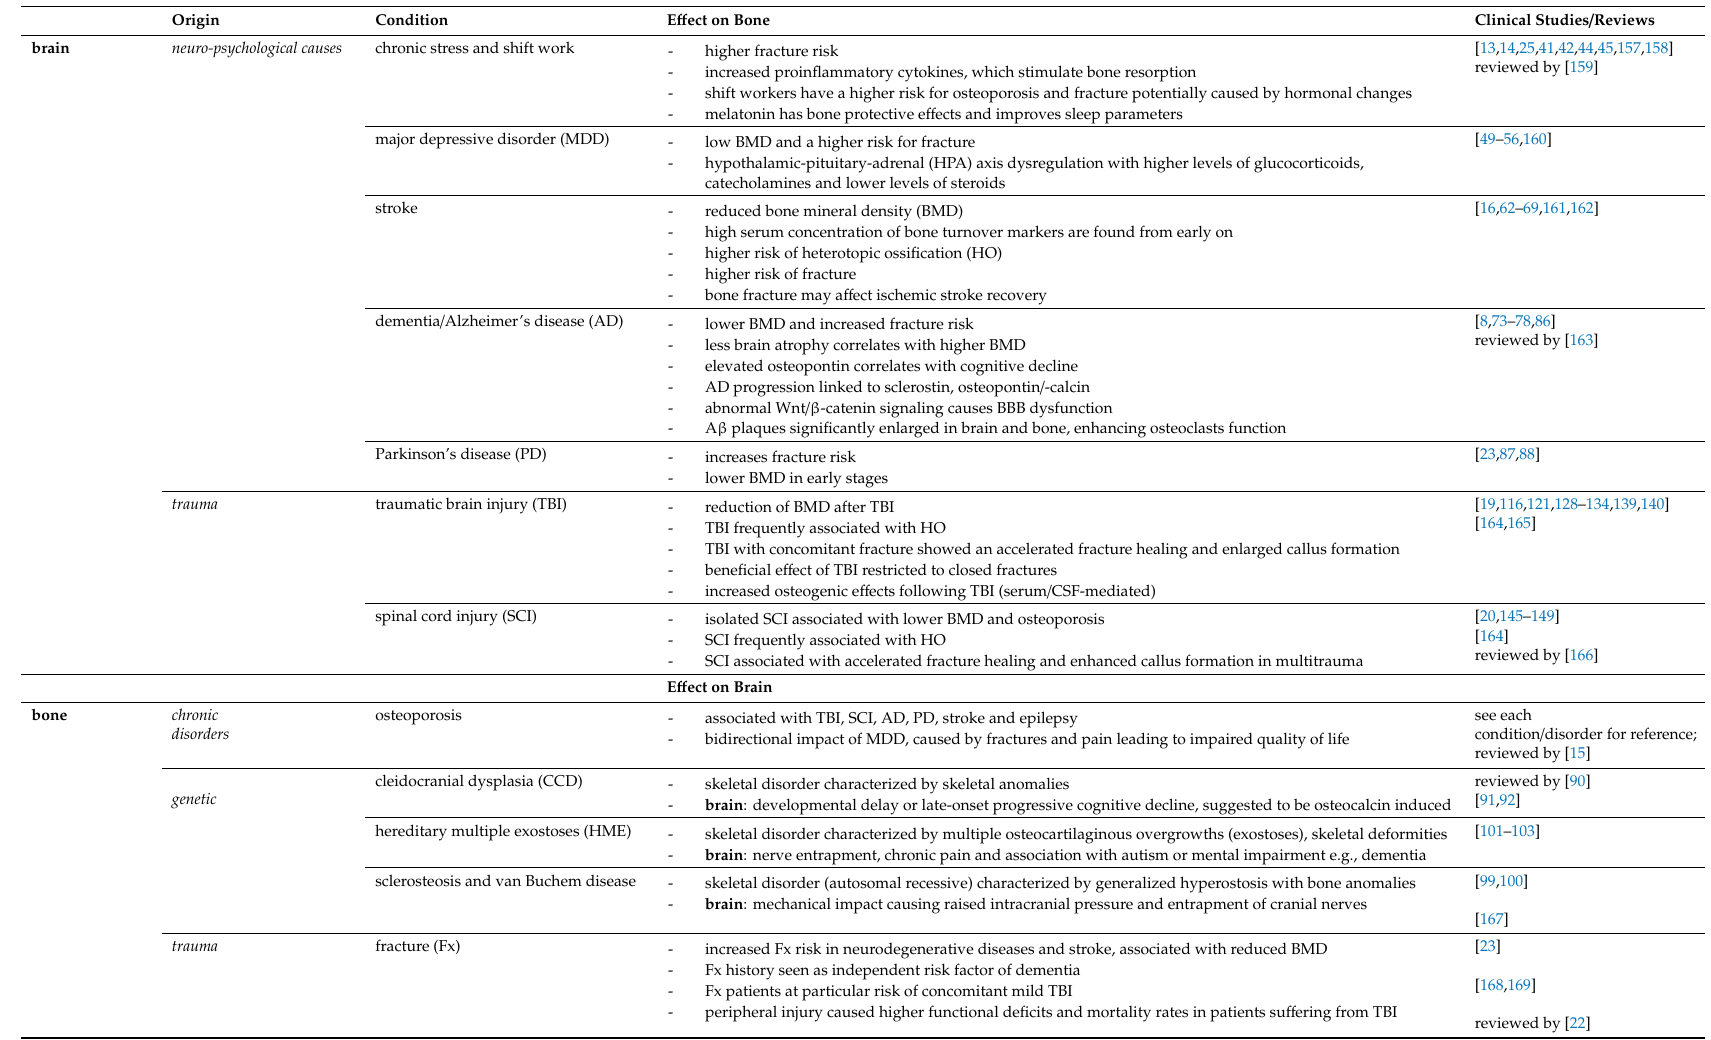
Table 1. Crosstalk of brain and bone: clinical